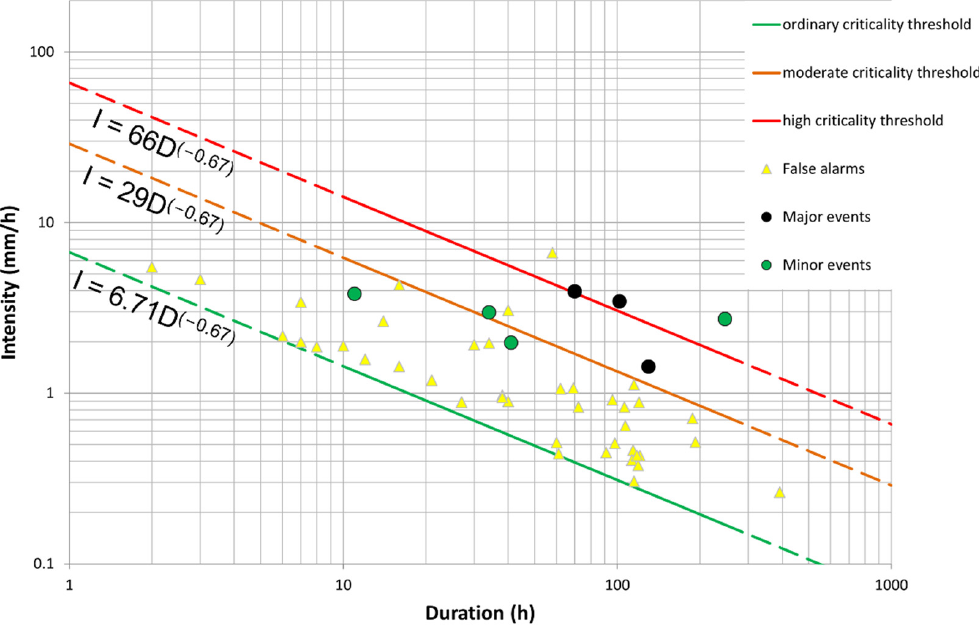
Figure 5. Comparison between the proposed set of rainfall thresholds and the validation dataset, providing evidence of correctly forecasted major events (black dots), correctly forecasted minor events (green dots), and false alarms (yellow triangles).